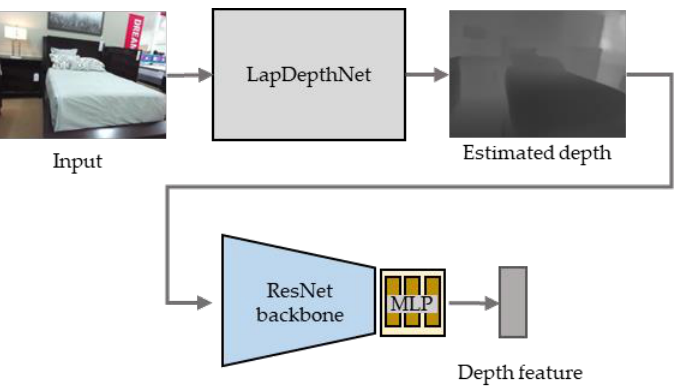
Figure 4. Architecture of the depth-feature generation network. The depth-feature generation net-